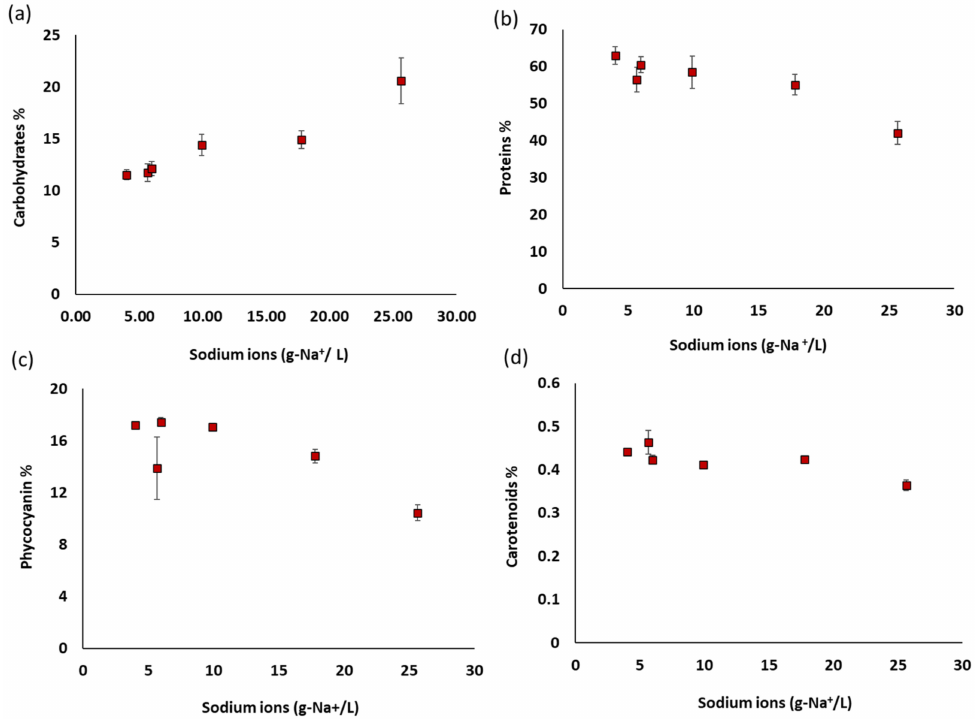
Figure 3. Selected biochemical compound content of A. platensis cultivated at different salinities in relation to the total sodium ions (Na + ); ( a ) carbohydrates, ( b ) proteins, ( c ) phycocyanin, and ( d )